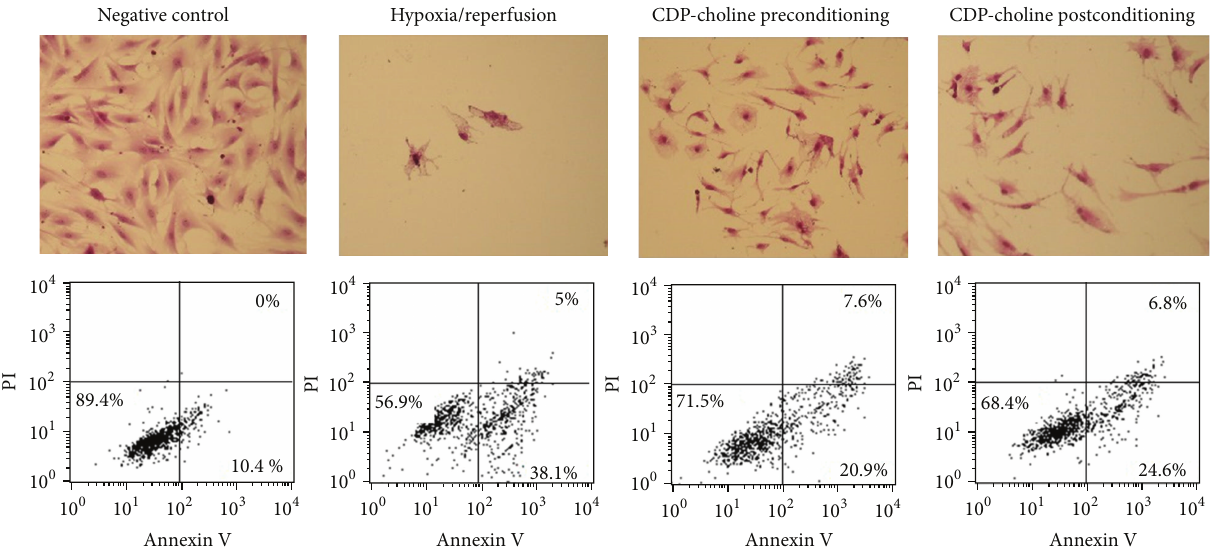
Figure 3: CDP-choline attenuates hypoxia/reperfusion-induced apoptosis. Cardiac myocyte cultures were subjected to coverslip hypoxia/reperfusionalone(Hypoxia/reperfusion),incubatedwithCDP-choline(50 mg/mL)priortoreperfusion(CDP-cholineprecondition- ing), or incubated with CDP-choline (50mg/mL) 1hr after reperfusion (CDP-choline postconditioning). Cell cultures were left untreated as a control (Negative control). After treatment, the cells were stained with hematoxylin-eosin; cell morphology was assessed by light microscopy (40X) (upper panel). Apoptosis and necrosis were evaluated by flow cytometry analysis of cells labeled with Annexin-V-FLUOS (Annexin V) and propidium iodide (PI) (lower panel). The proportion of labeled cells is depicted in the lower panel. The proportion of viable cells, with low Annexin and low PI staining, is shown in the left, lower quadrant of each dot plot. Apoptotic cells, with high Annexin and low PI staining, are depicted in the right, lower quadrant. Necrotic cells, with high Annexin and high PI staining, are showed in the right, upper quadrant. Results shown are representative figures from three independent